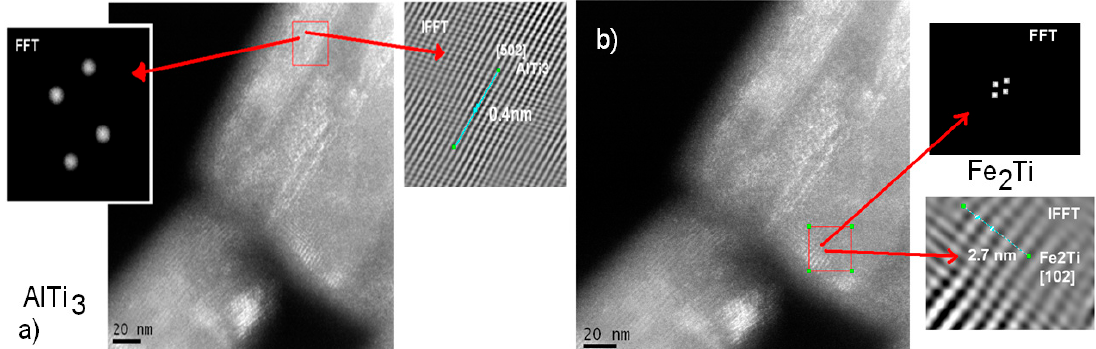
Figure 8. Darkfield analysis of the phases in the rods ( a ) on one side and ( b ) in the center of the rods. We observed that the center is formed mainly by the Fe 2 Ti phase and the side by the AlTi 3 phase. The contrast of the photo indicates intercalations of these phases, especially on the side of the rod.